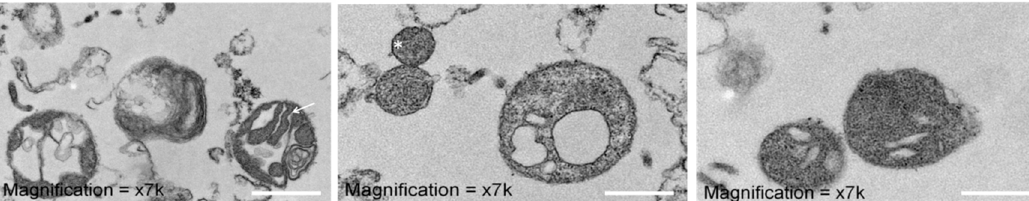
Figure 6. Ultrastructure of device-extracted mitochondria was detected by transmission electron microscopy (TEM). Scale bar is 0.5 μ m in each image. The arrow and star indicate the mitochondrial cristae and condensed ultrastructural transformation, respectively.